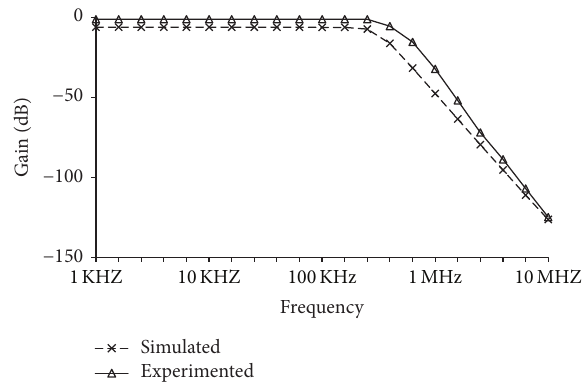
Figure 17: Simulated and experimented magnitude response of 4th- order low pass